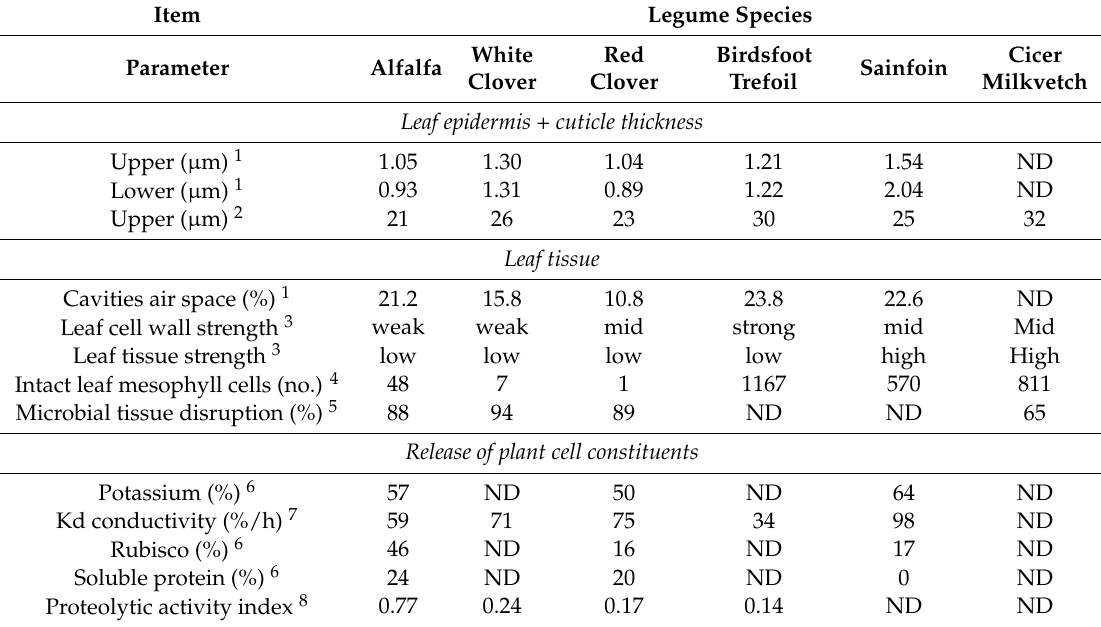
Table 1. Composition, tissue disruption and release of nutrients in leaves of several temperate forage legumes. Item Legume Species Parameter Alfalfa